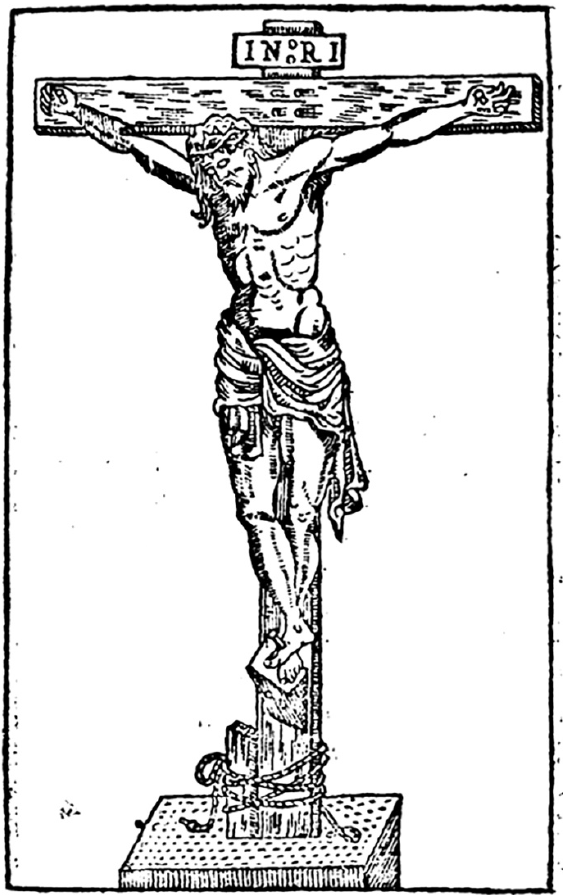
Figure 3. Anonymous. Cristo en la cruz , Pedro de Medina: Victoria gloriosa, y excelencias de la esclarecida Cruz de Iesu Christo …, p. 370.